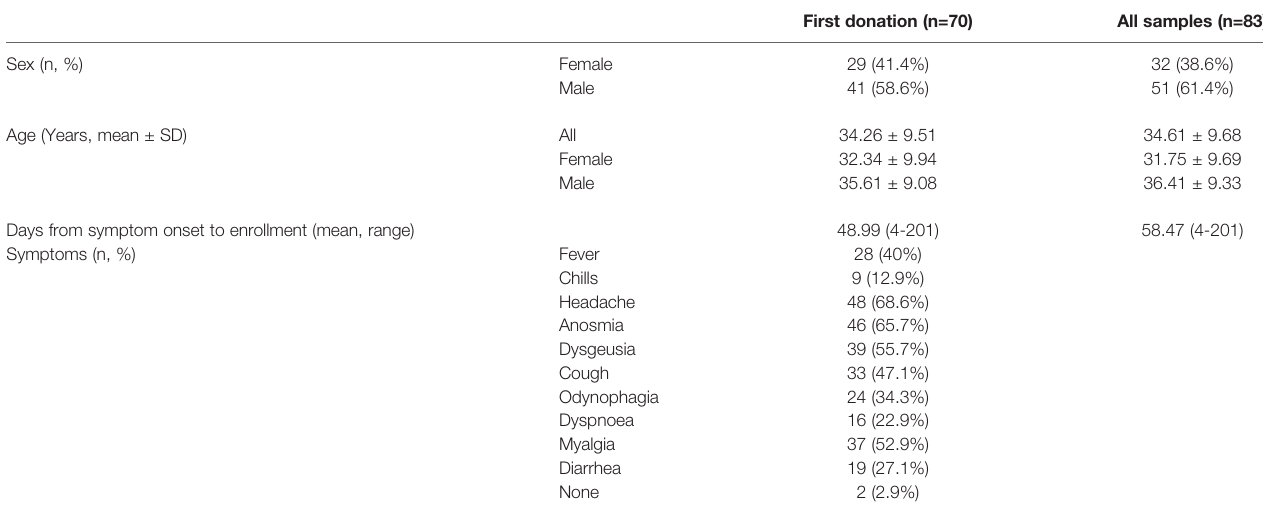
TABLE 1 | Demographics and clinical characteristics of the